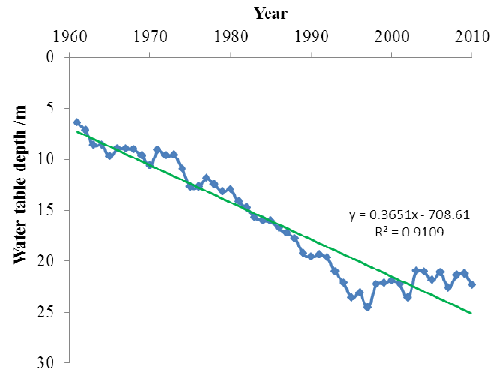
Figure 6. Change of annual average water table depth during